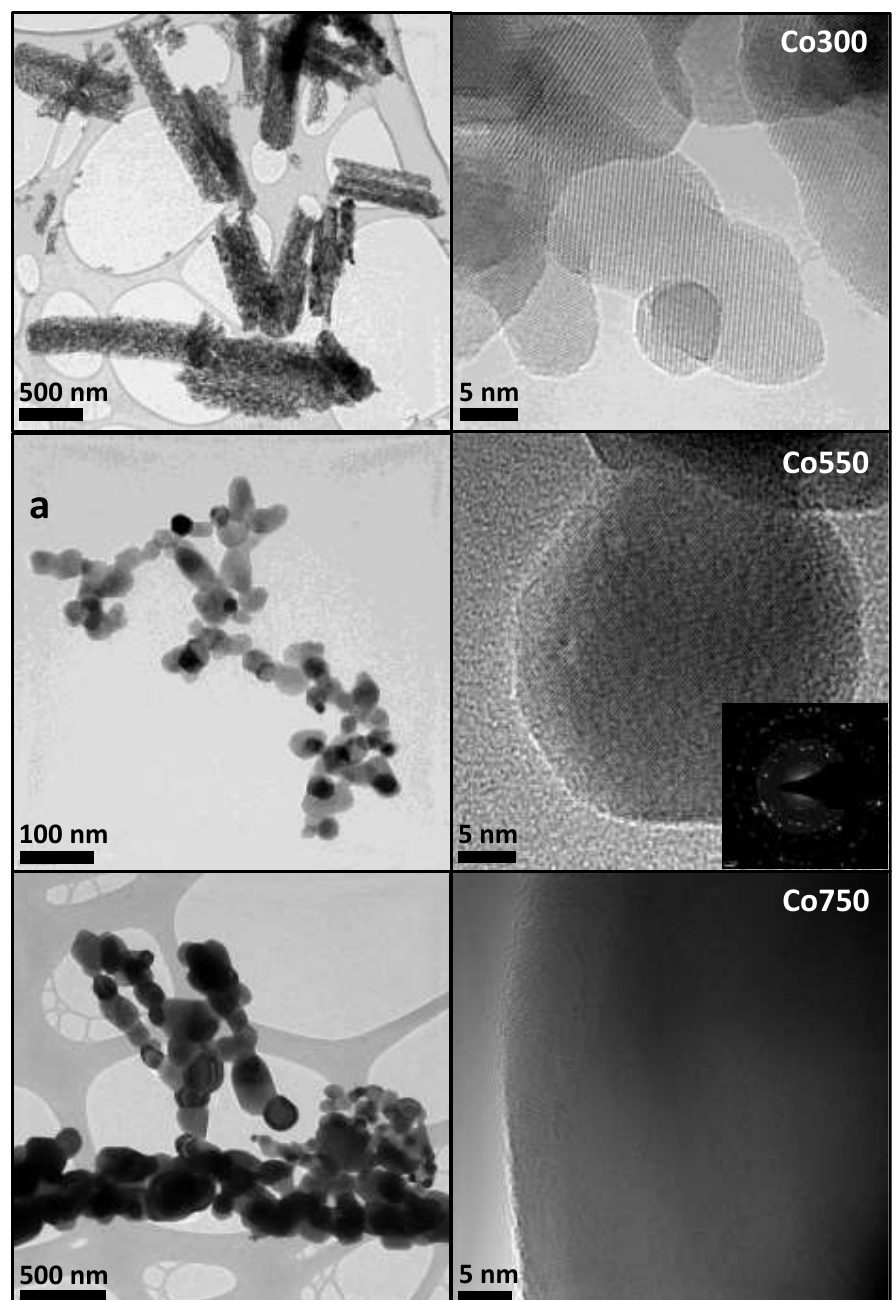
Figure 4. High-resolution transmission electron micrographs (HRTEMs) at lower ( left ) and higher ( right ) magnification of the Co 3 O 4 catalysts calcined at different temperatures: 300 °C (Co300), 550 °C (Co550), and 750 °C (Co750).